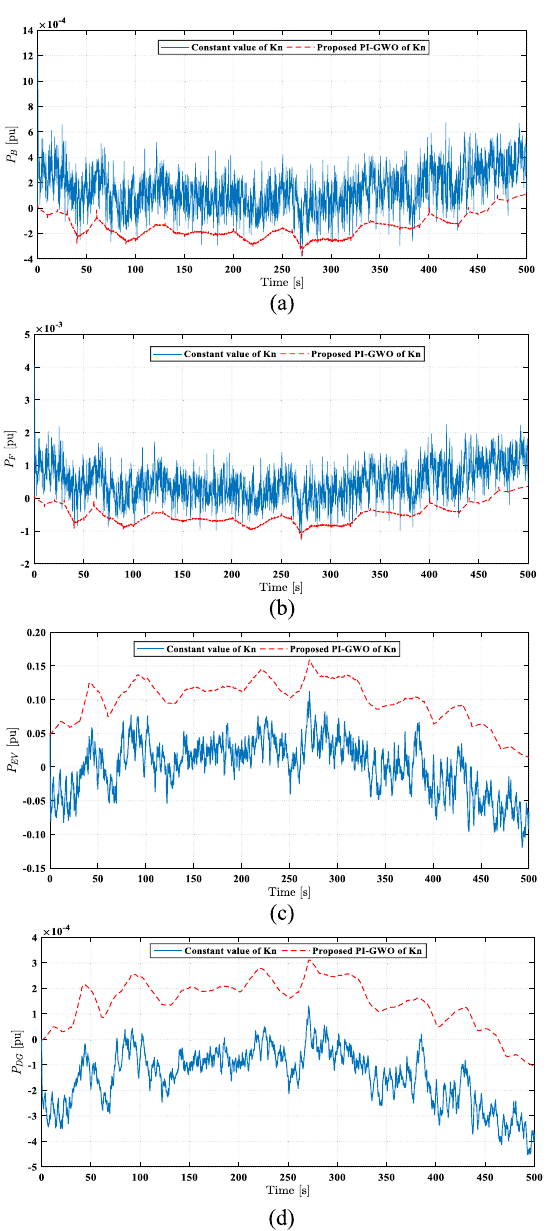
Fig. 13 The performance of HGS sources for Case 2: a battery power, b flywheel power, c EV power, and d DG power